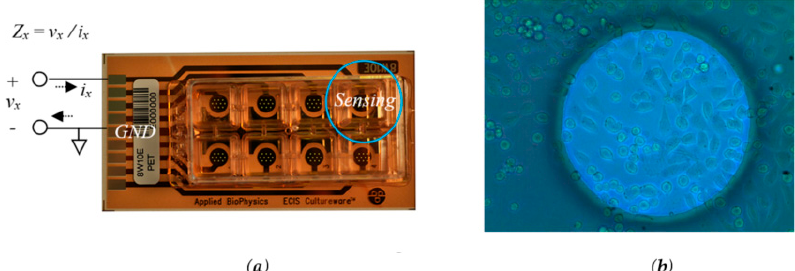
Figure 2. The ECIS Cultureware 8E10W device ( a ); composed of 8 separated wells for cell culture containing a 10 units of 250 μ m diameter Au microelectrode. The measure bioimpedance Z x represents the ratio v x /i x . ( b ) a Chinese hamster ovary fibroblast cell line, AA8 (American Type Culture Collection), cultured over the surface of a single microelectrode.